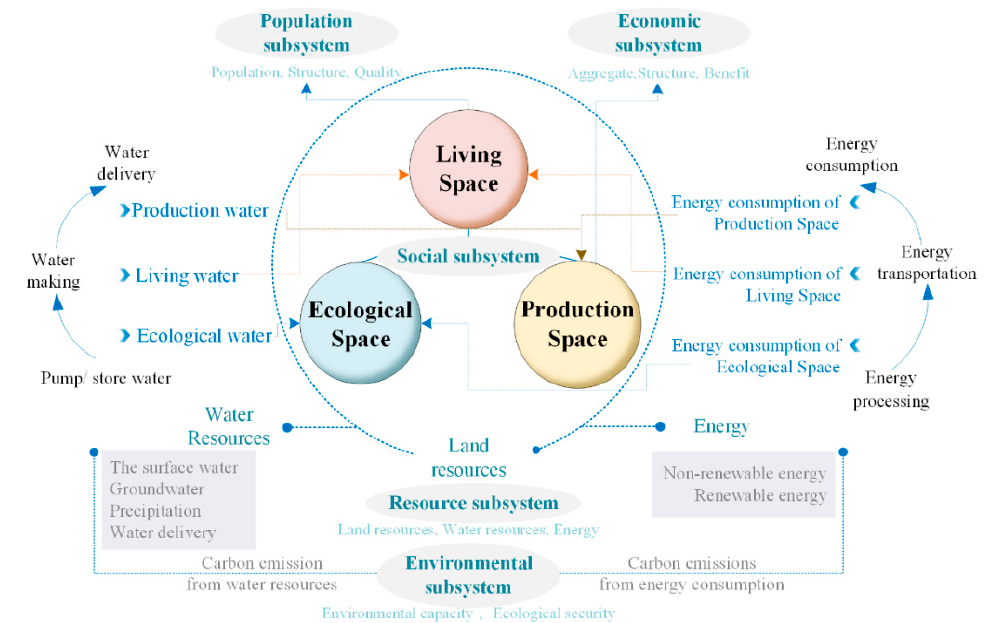
Figure 1. Habitable Earth: the systematic production–living–ecological space (Lin, G. [1]).